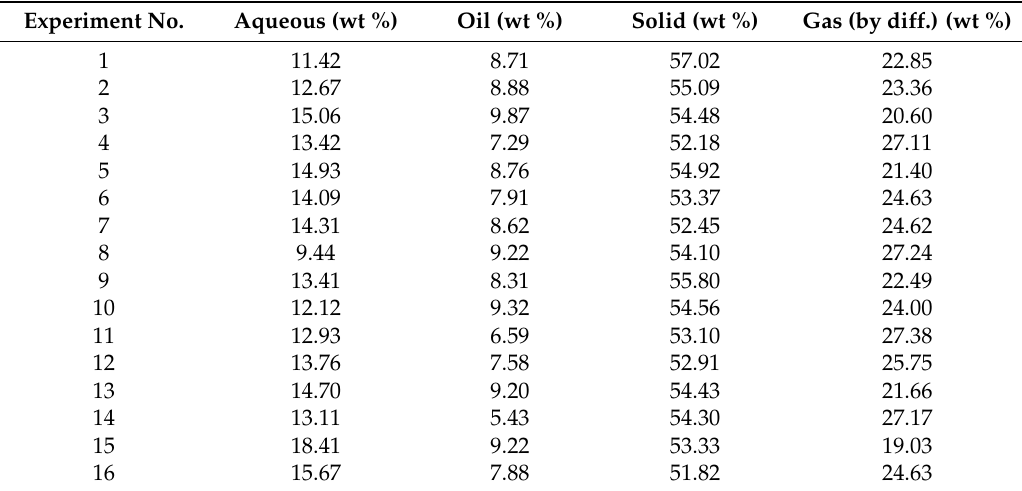
Table 4. The mass balances of all 16 experimental